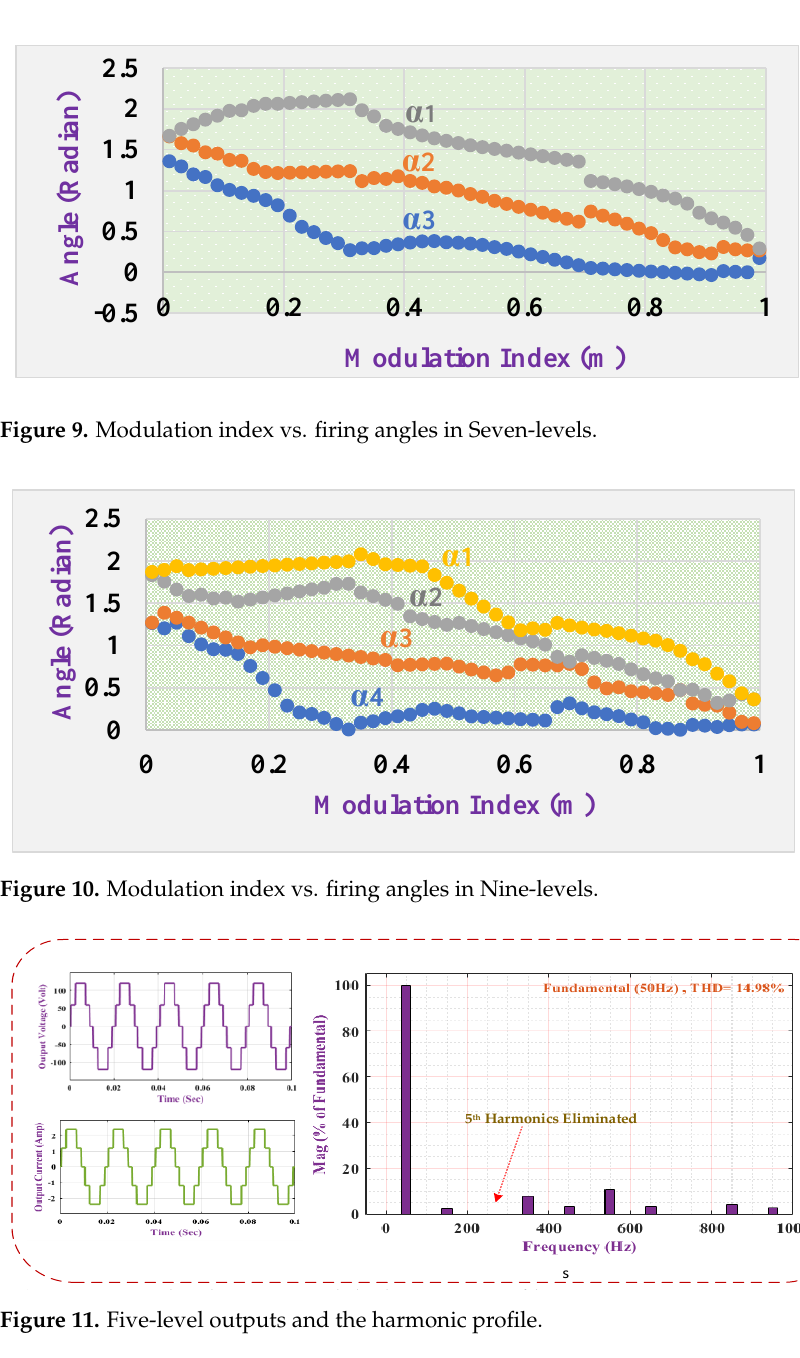
Figure 8. Modulation index Vs firing angles in Five-levels.